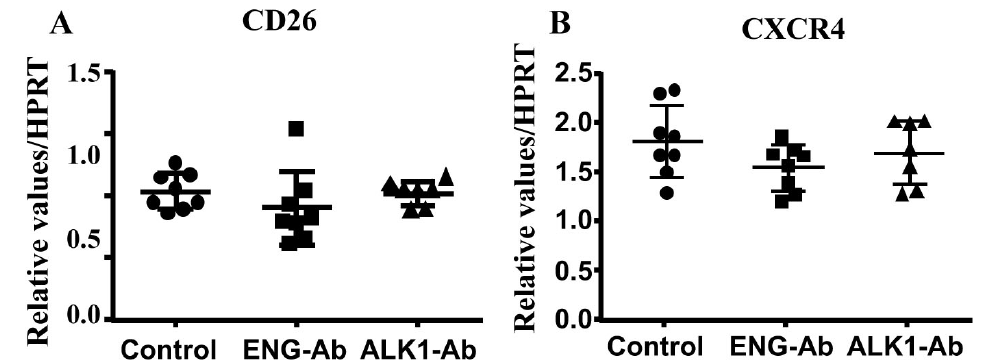
Figure 5. ENG or ALK1 antibody (Ab) treatment did not alter CD26 and CXCR4 expression. A. Quantification of CD26 expression. B. Quantification of CXCR4 expression. N = 8 for control; N = 8 for ENG-Ab group; N = 7 for ALK1-Ab treated group. Control: corresponding control IgG treated MNCs; ENG-Ab: ENG antibody treated MNCs; ALK1-Ab: ALK1 antibody treated MNCs